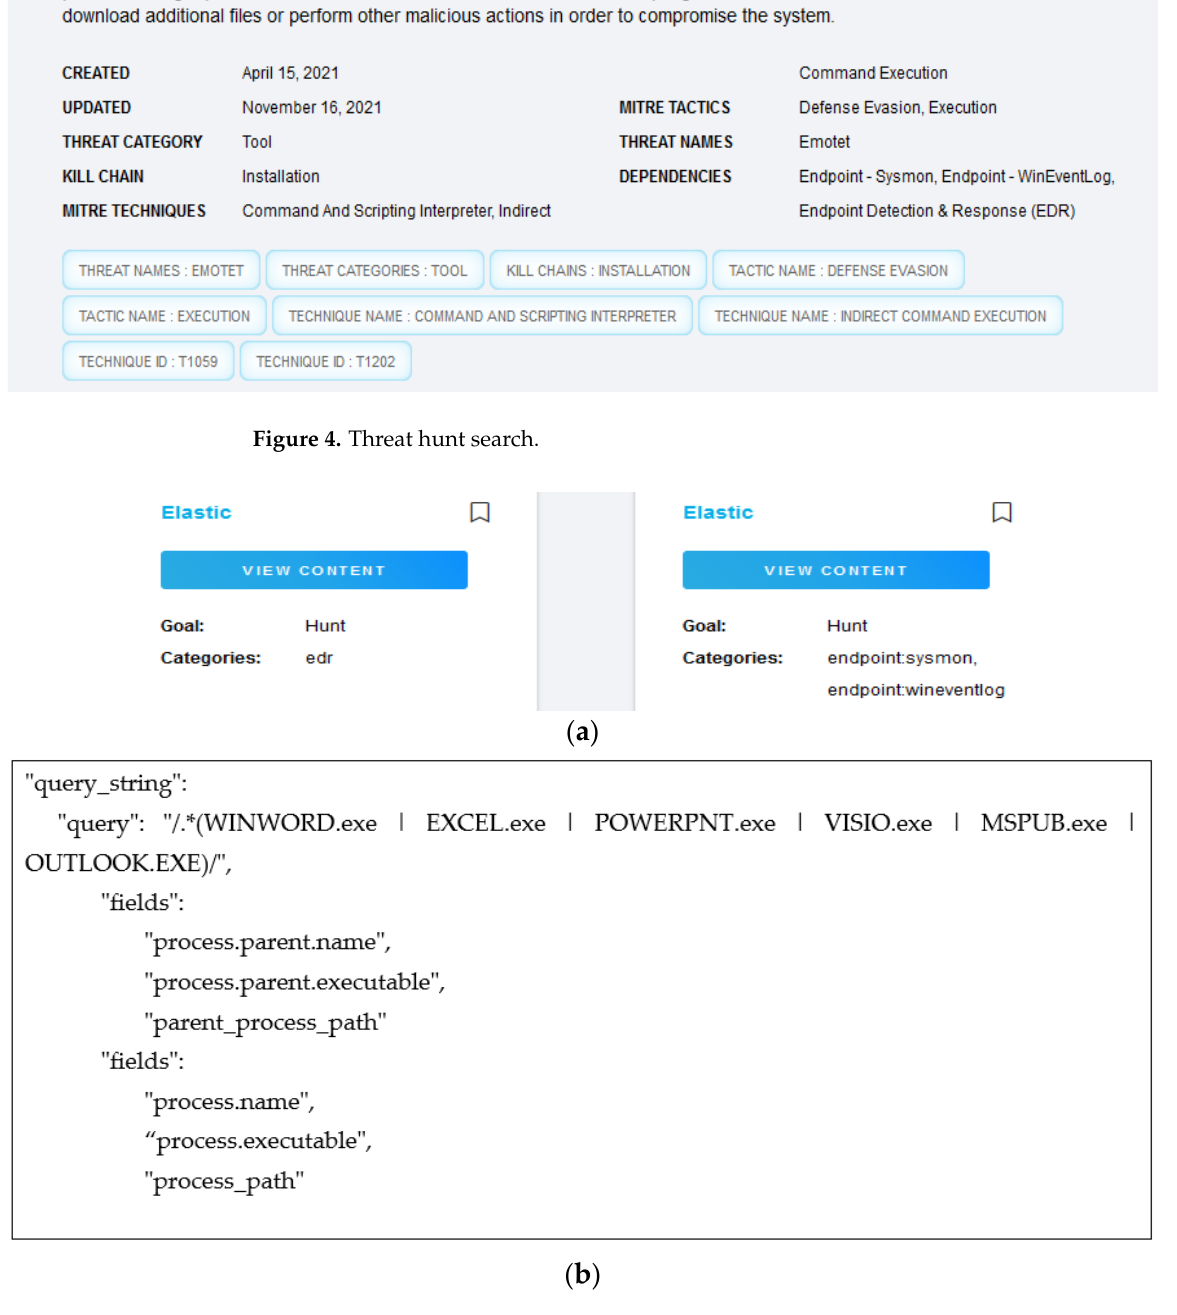
Figure 6. Script reported threat activities. To validate the findings, on filtering two variables ‘process.parent.executable’ and ‘process.executable’ and Figure 7 illustrates Microsoft Excel launching multiple Windows command line terminals.